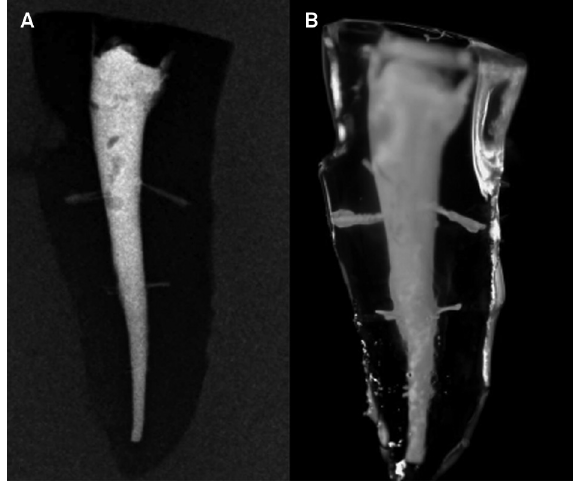
Figure 1. Analysis of filling material penetration into simulated lateral canals: radiograph (A) and photograph (B) of a specimen after decalcification and